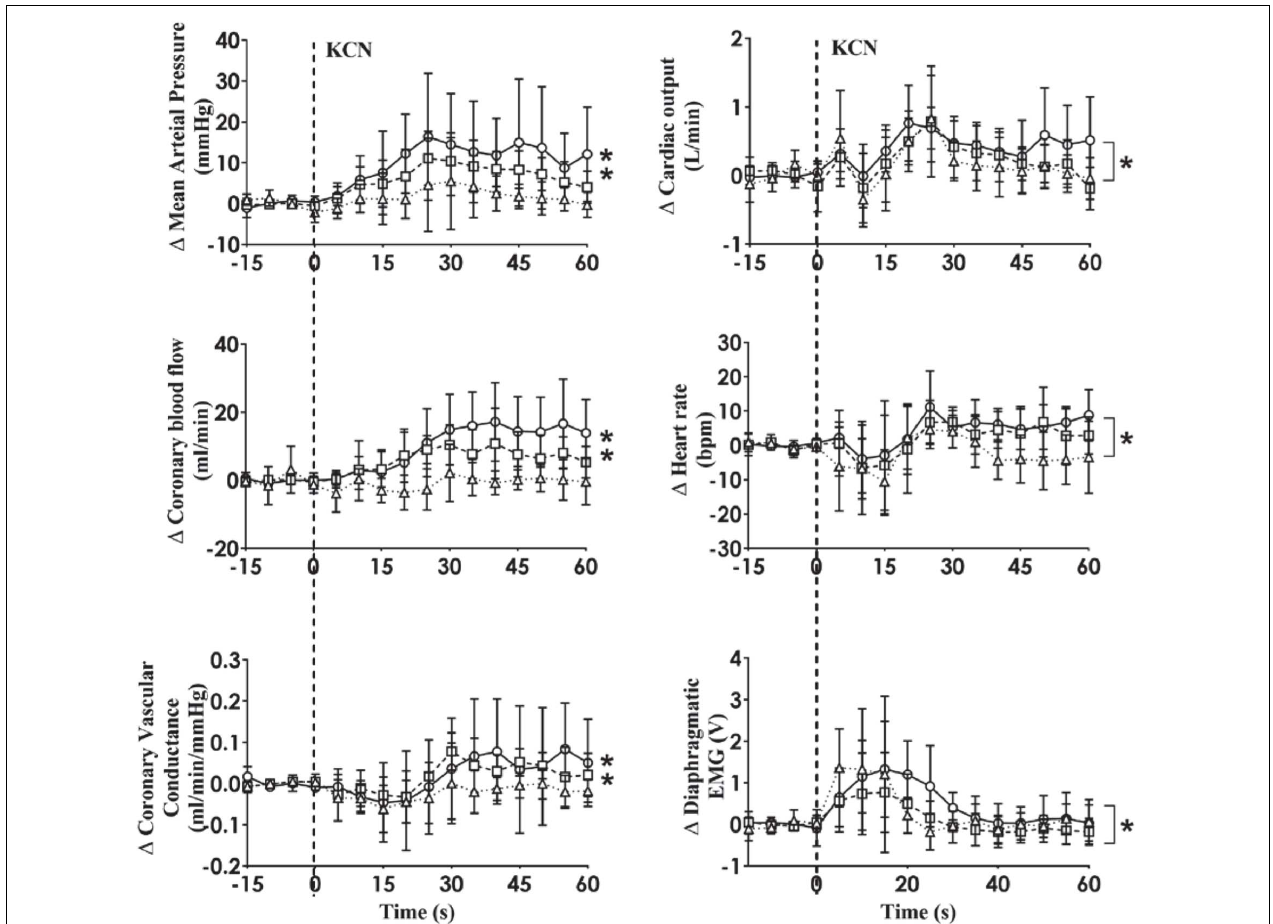
FIGURE 2 | Absolute change in mean arterial pressure, coronary blood flow, coronary vascular conductance, cardiac output, heart rate and dEMG responses ( n = 6) to intra-carotid potassium cyanide (KCN; 10 µ g/kg (triangles and dotted line), 20 µ g/kg (squares and interrupted line), and 30 µ g/kg (circles and solid line) injection in sheep with HF. Data are mean ± SD. * p <